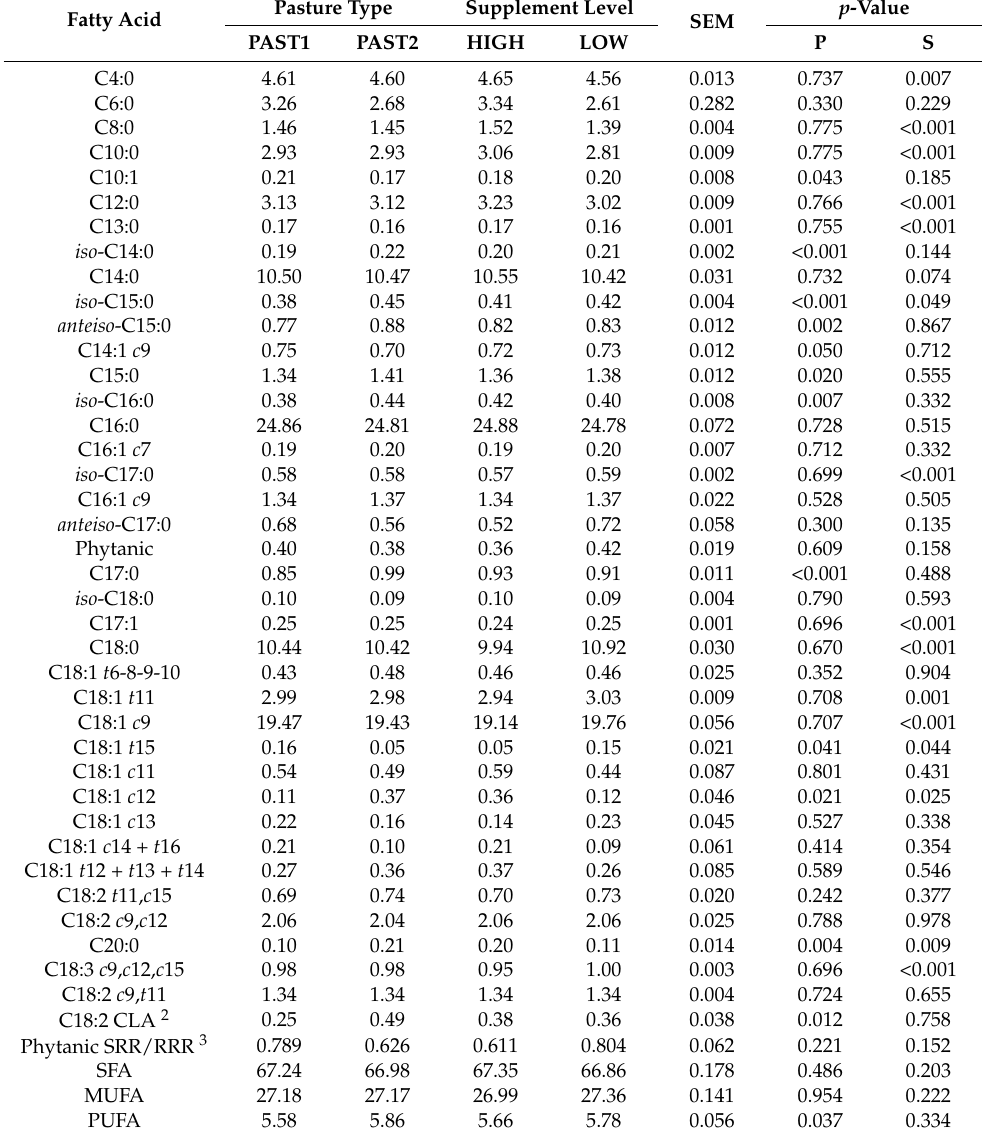
Table 3. Fatty acid composition (g/100 g of total fatty acids) of cheese as affected by pasture type and supplement level; n = 12 1